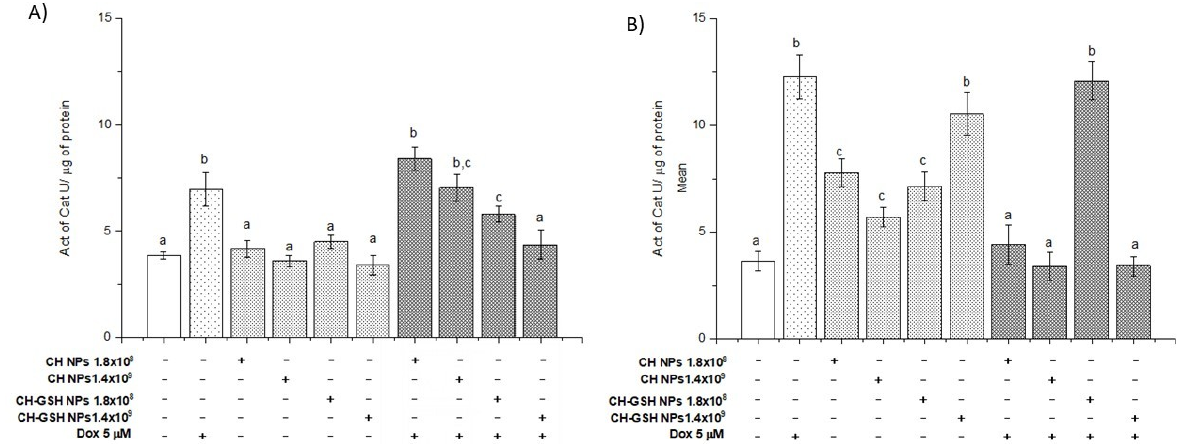
Figure 7. The activity of catalase. The cells were exposed to Dox for 12 h and then 2 h with CH-GSH NPs or CH-NPs. ( A ) MCF-7 and ( B ) MDA MB-231 cells. Bars with equal letters indicate no significant differences between the means (Tukey’s test, p < 0.05).